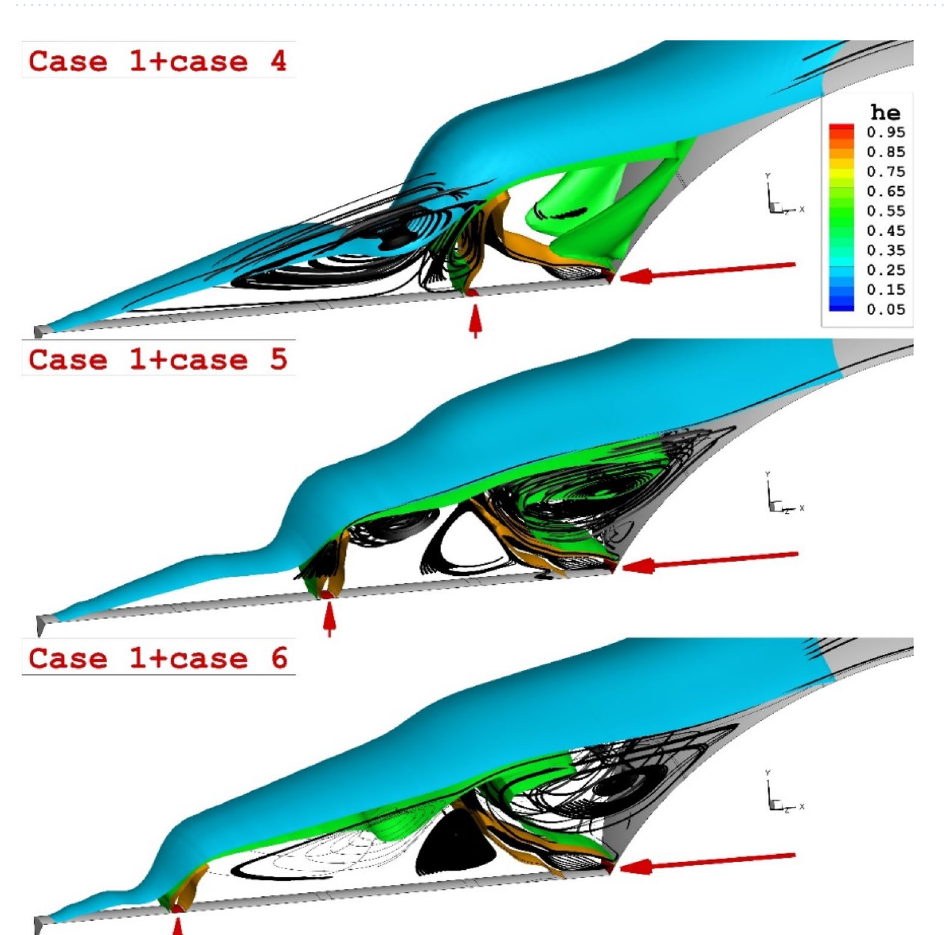
Figure 7. 3-D feature of hybrid helium jets around the main